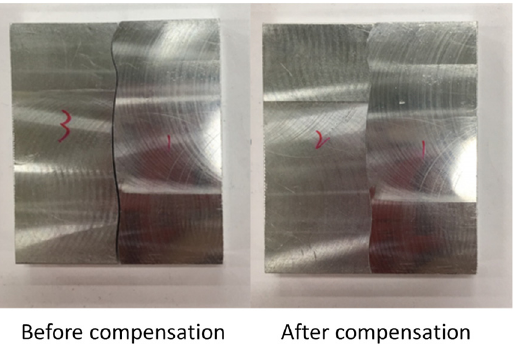
Figure 14. Comparison assembly curve mating before and after compensation.